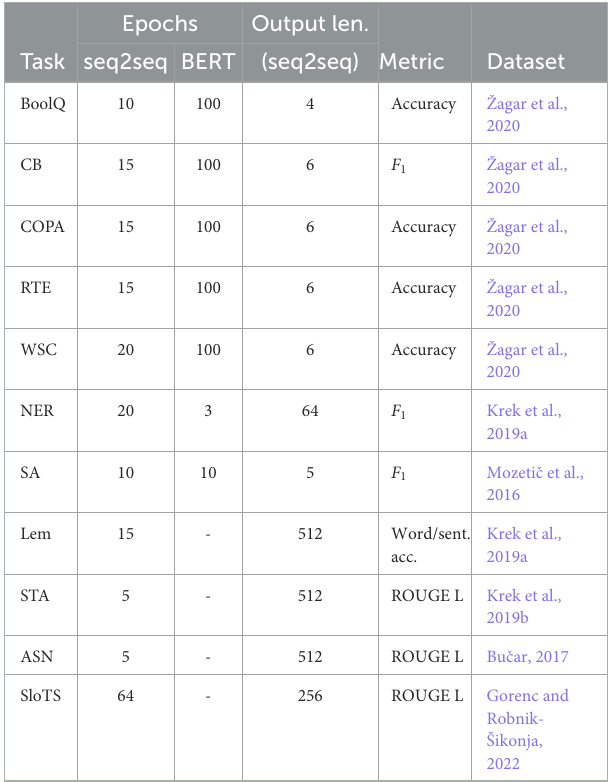
TABLE 4 Results of the compared T5 and BERT models on classification